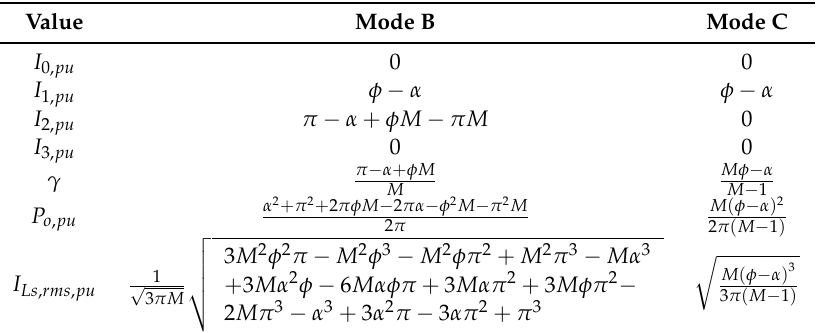
Figure 5. Equivalent circuits corresponding to the first four intervals in Mode B: ( a ) Interval 1 [0, φ − α ]; ( b ) Interval 2 [ φ − α , π − α ]; ( c ) Interval 3 [ π − α , γ − α ]; ( d ) Interval 4 [ γ − α , π ].